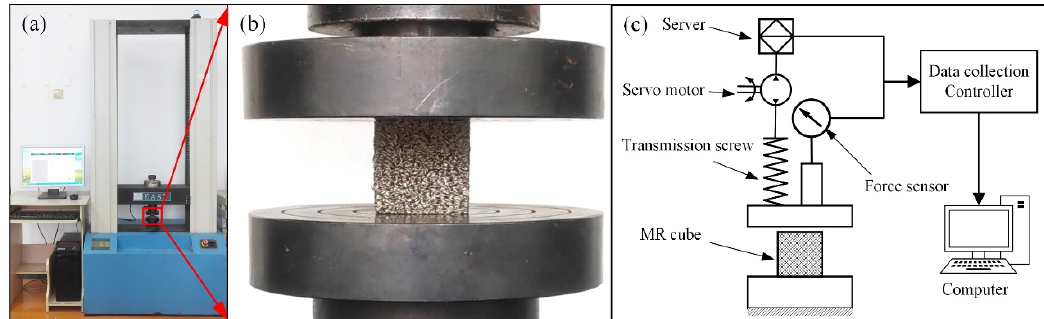
Figure 5. Uniaxial compression experiments of MR cube: ( a ) universal testing machine; ( b ) MR cube; ( c ) schematic of the compression experiment.